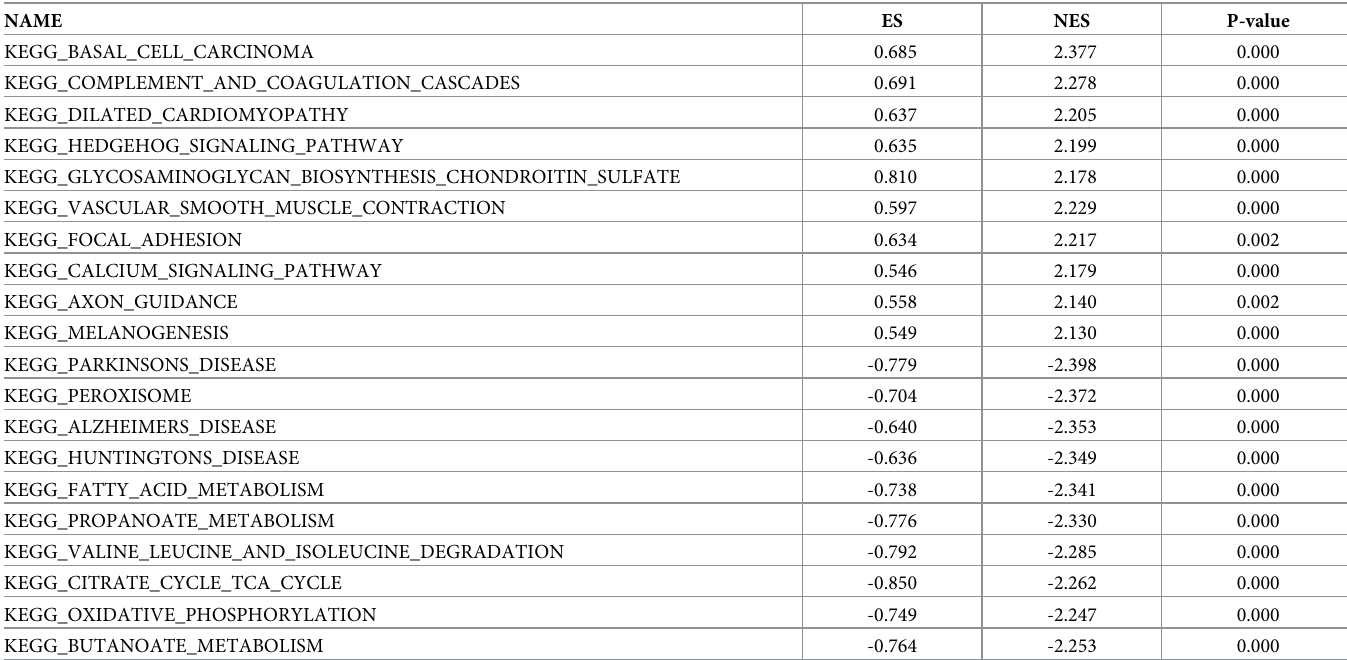
Table 4. GSEA enrichment analysis results in the TCGA-CRC cohort (top 20).